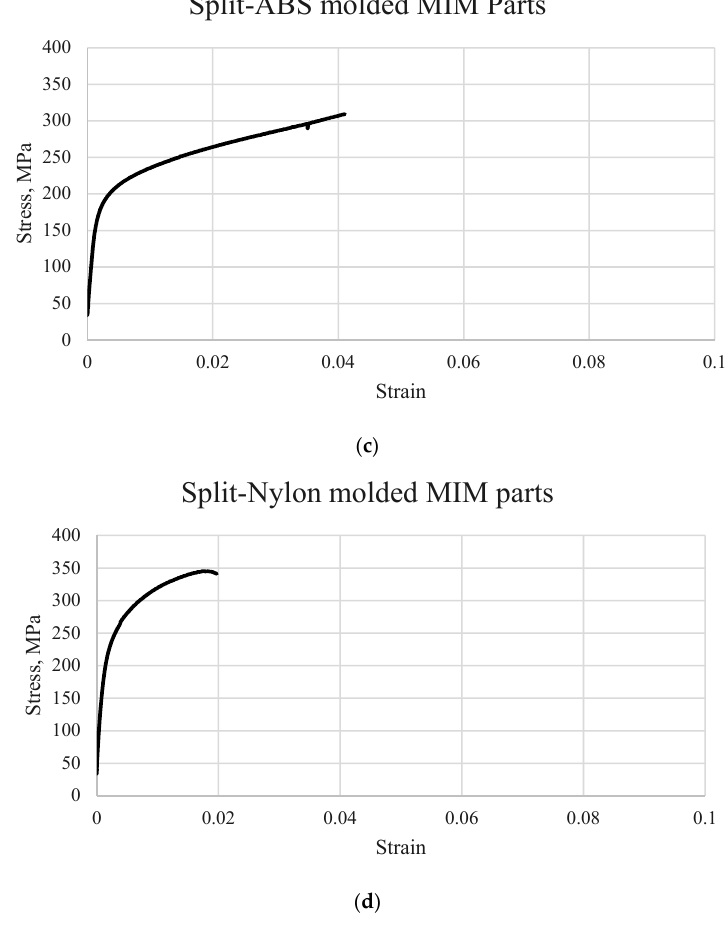
Figure 12. Stress-strain graphs of SS 316L molded through ( a ) aluminum mold insert, ( b ) copper plated ABS mold insert, ( c ) ABS Split mold insert, and ( d ) nylon split mold insert. Figure 13 indicates the comparison between the molded and sintered parts tensile testing strength with the benchmark part and literature values. Metals 2018 , 8 , x FOR PEER REVIEW